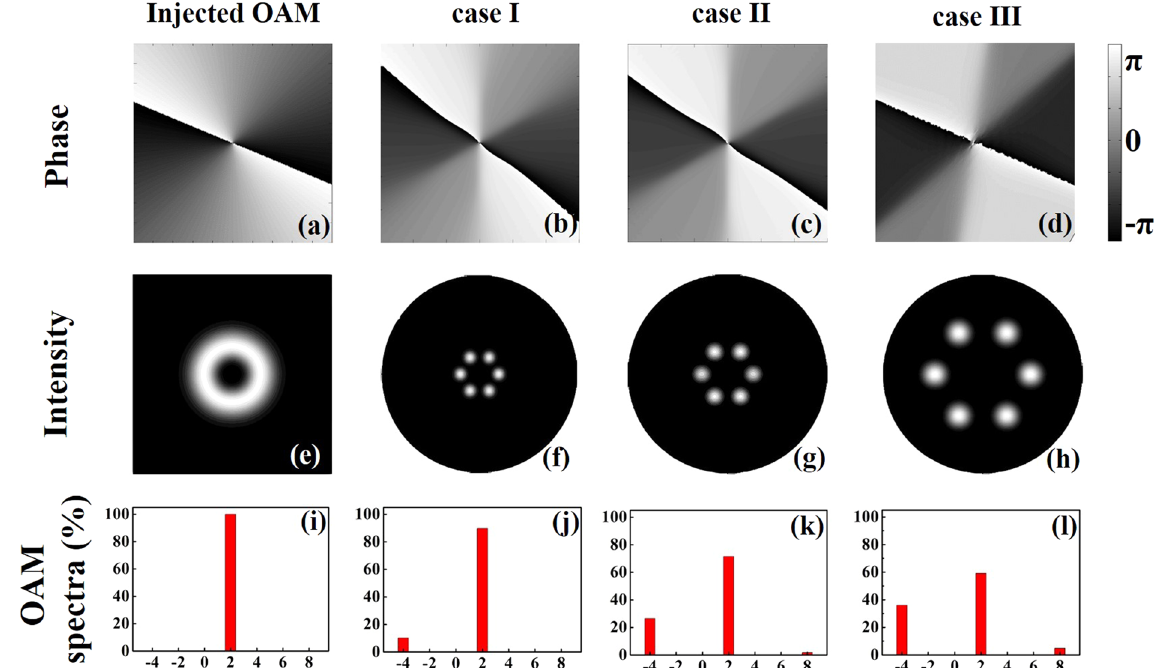
Figure 2. Phase profiles, intensity profiles and OAM spectra. ( a,e,i ) The injected OAM 2 beam, ( b,f,j ) the transmitted beam for case I ( r = 4 μ m, d = 12 μ m), ( c,g,k ) case II ( r = 6 μ m, d = 16 μ m), and ( d,h,l ) case III ( r = 10 μ m, d = 30 μ m). In Fig. 2(i–l), the x-coordinate and y-coordinate mean topological charge numbers and normalized power weight,